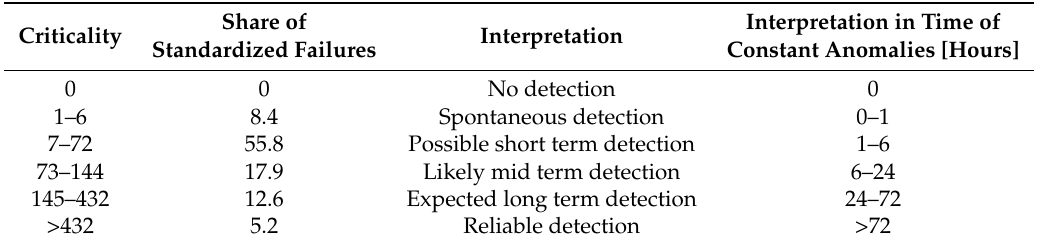
Table 6. Potential scheduling